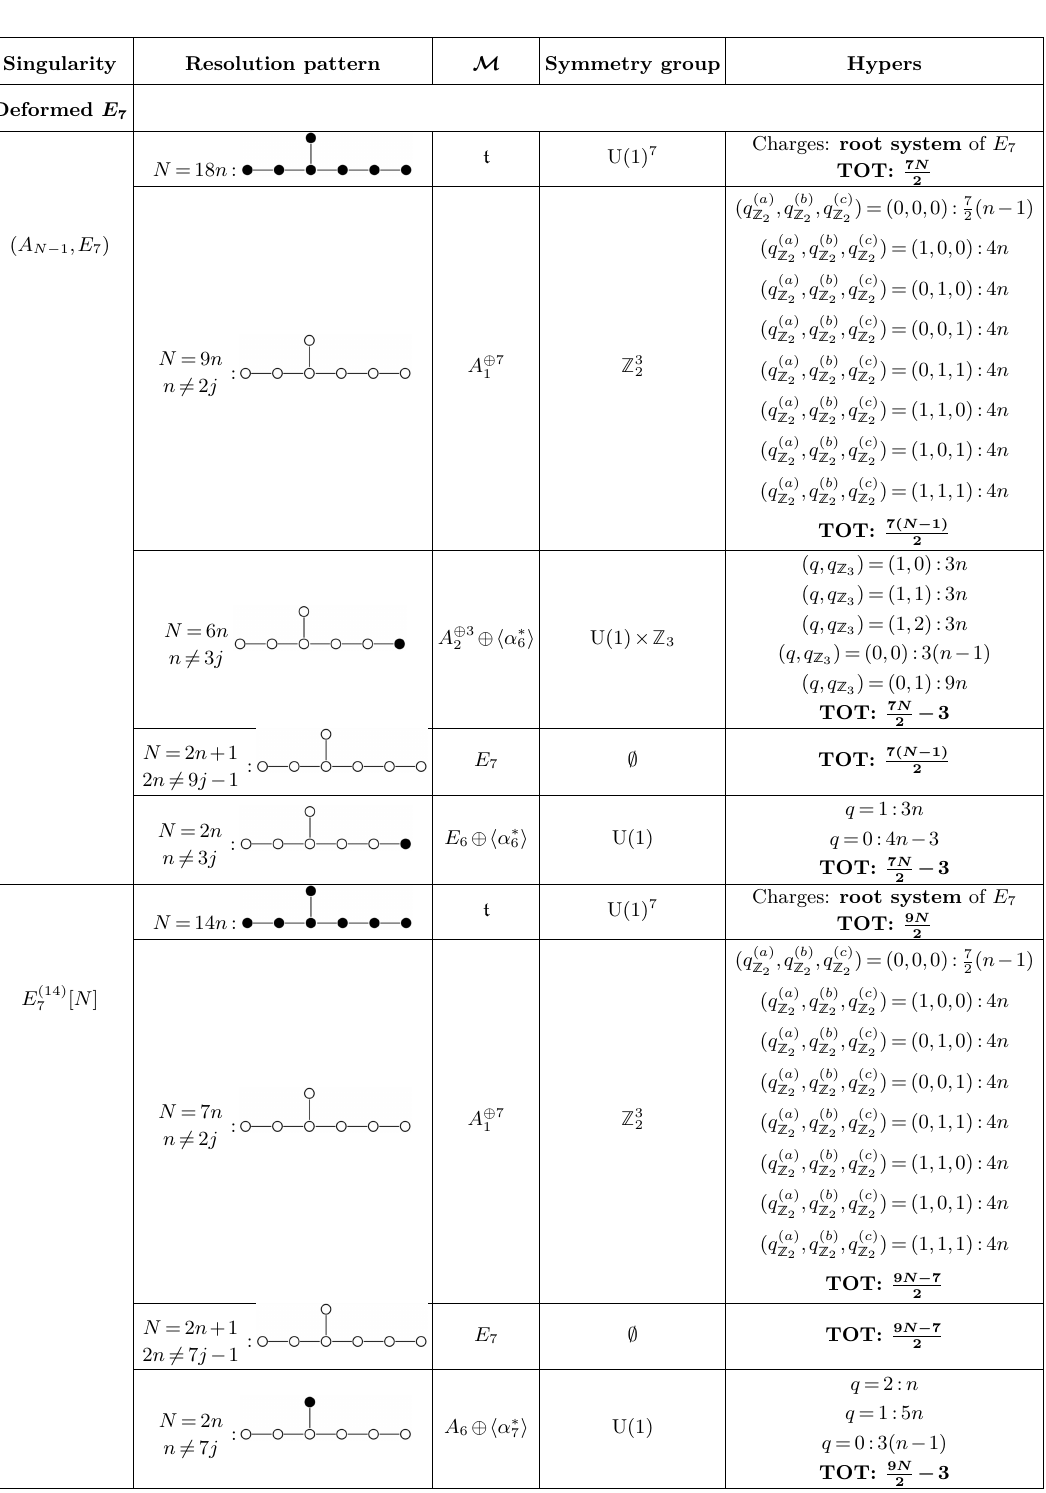
Table 7 . Higgs branch data for quasi-homogeneous cDV singularities of ( A N − 1 , E 7 ) and E (14)